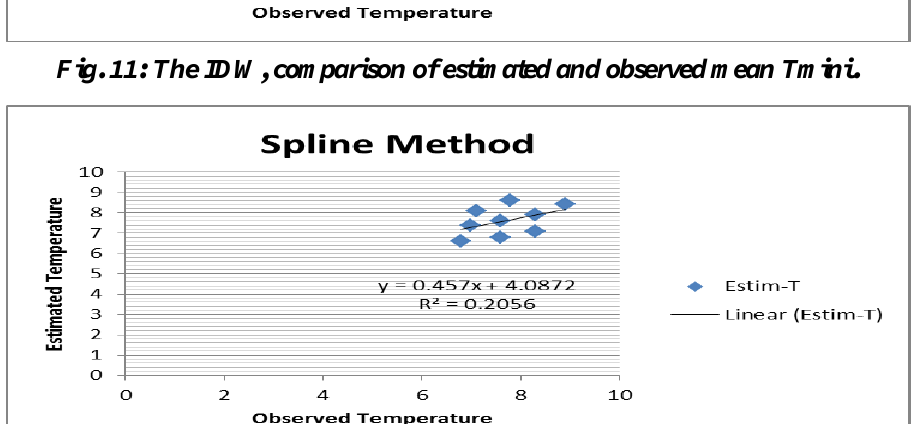
Fig.12: The Spline, comparison of estimated and observed mean Tmini.